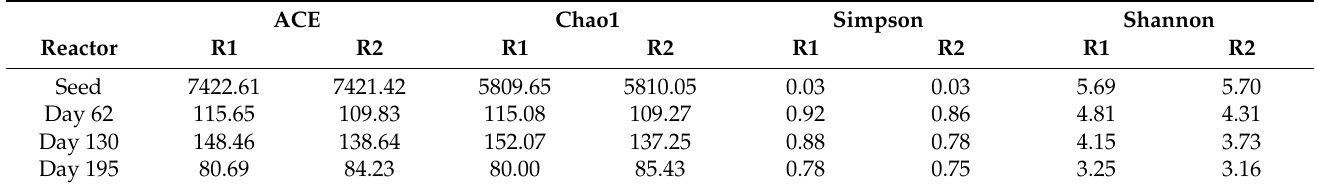
Table 4. The alpha diversity indices of the species in aerobic granules in R1 and R2. ACE Chao1 Simpson